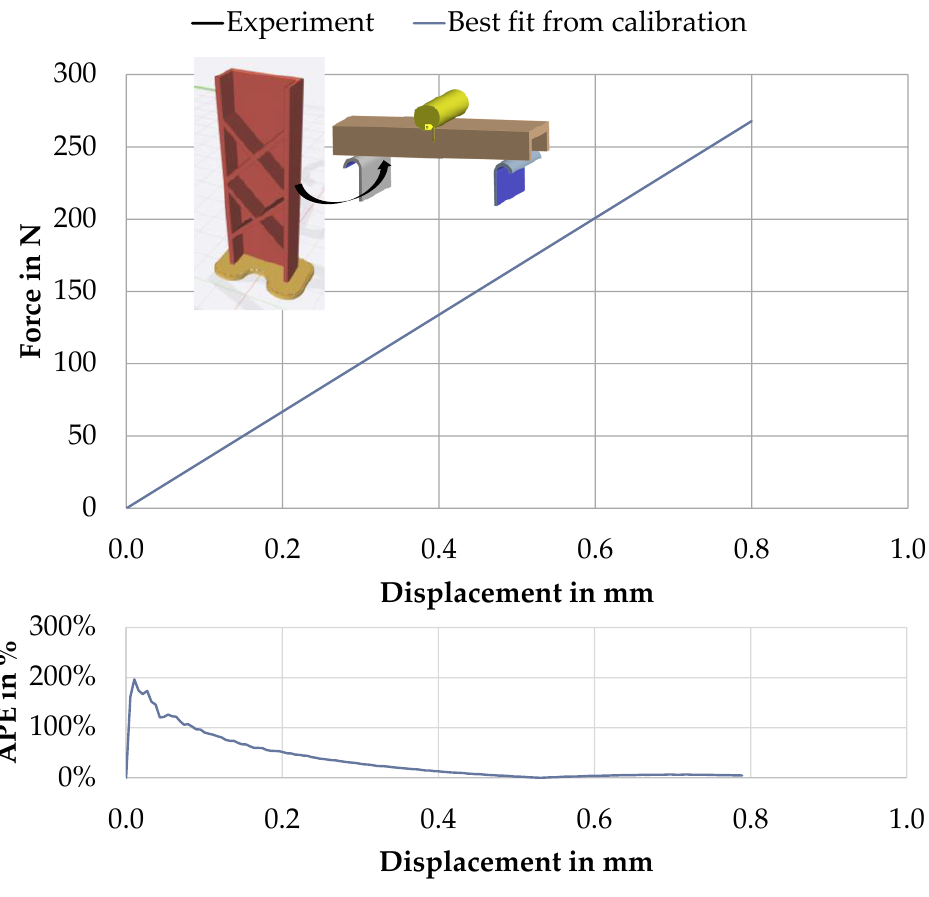
Figure 14. Calibrated material model applied to upright-printed XX-rib specimen bending simulation compared to experimental result (force-displacement-curve above, average percentage error (APE) below; MAPE = 35%).